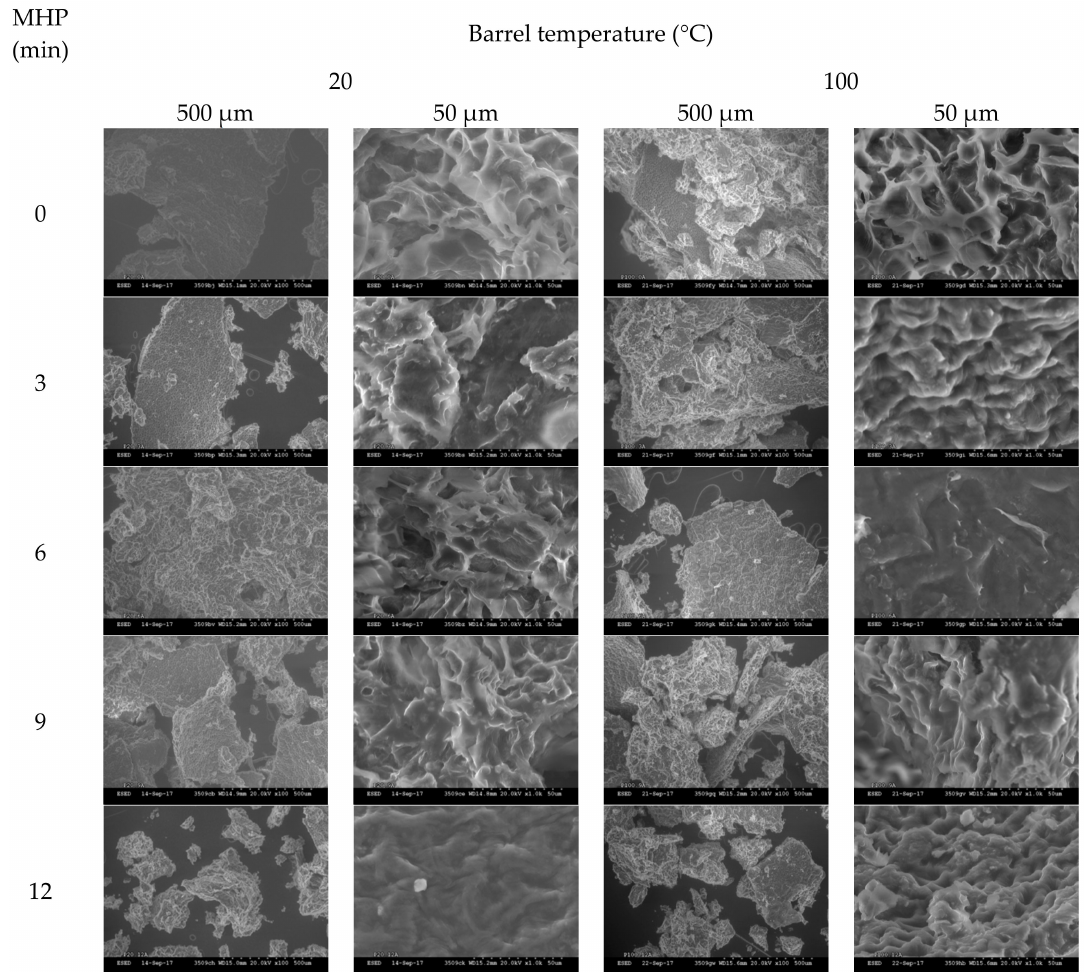
Figure A5. Representative scanning electron photomicrographs of cold-pressed (20 ◦ C) and expeller (100 ◦ C) meal treated with increasing durations of moist heat pressure (MHP, 0–12 min) post proteolytic digestion. Images were taken with × 1.0 k and × 0.1 k